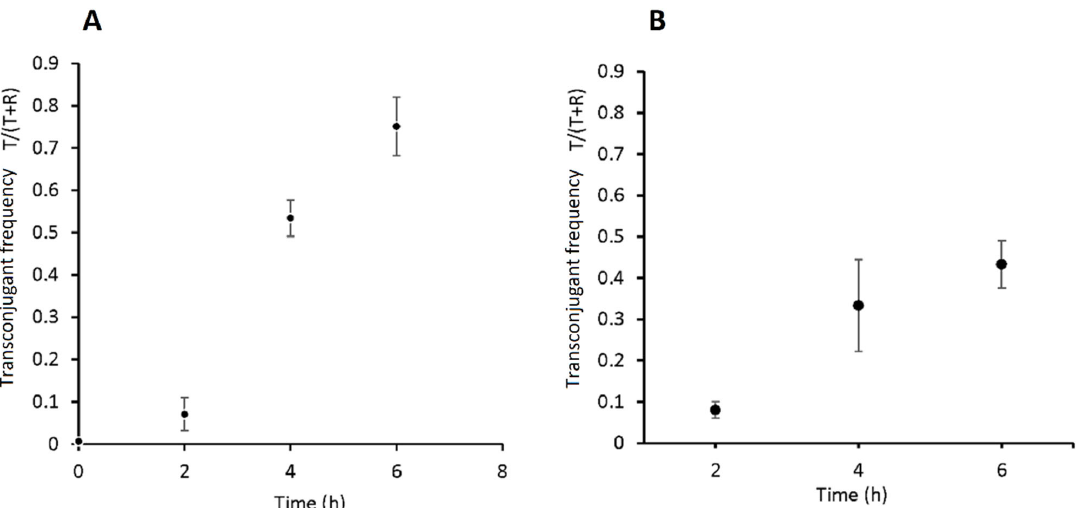
Figure 5. Transconjugant frequency in the conjugation mix comprising the J53Az + p_mCherry ‐ sta ‐ ble recipient and UB5201Rf + pConj_blue ‐ strong donor strains over 6 h of filter mating. Conjugation frequency measured using flow cytometry ( A ) and the conventional selective agar plate count method ( B ). Data points are the mean T/(T+R) of four biological replicates ( n = 4) with error bars denoting standard error of the mean.